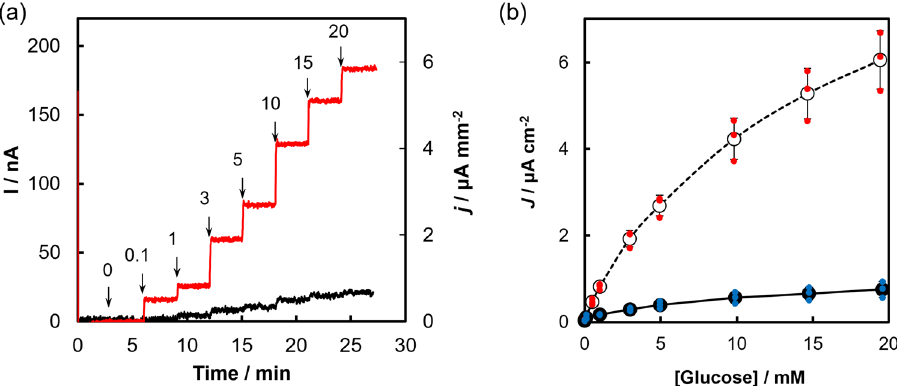
Fig. 5 Amperometric evaluation of BcGDHs. BcGDH enzymes were modi fi ed on gold disk electrode (2 mm φ ) and characterized as direct electron transfer type glucose sensors. Chronoamperometric evaluation of BcGDH immobilized enzyme electrode using DSH SAM at + 200 mV (vs. Ag/AgCl) were carried out in 100 mM potassium phosphate buffer (pH 7.0). a Representative time course of amperometric measurements. Arrows and the numbers above indicate the addition point of glucose and its concentration (in mM). Time course of control and α P205C/ β D383C- γ K155C/ β Y349C are shown as black and red lines, respectively. b Calibration curves of control and mutant BcGDH show as black closed circles and open circles, respectively. Evaluations were carried out in triplicate, and error bars indicate the respective standard deviation ( n = 3, mean value ± SD). All data points for control or mutant enzyme are shown in blue or red small circles, respectively. Numerical Data for Fig. 5 can be found in Supplementary Data